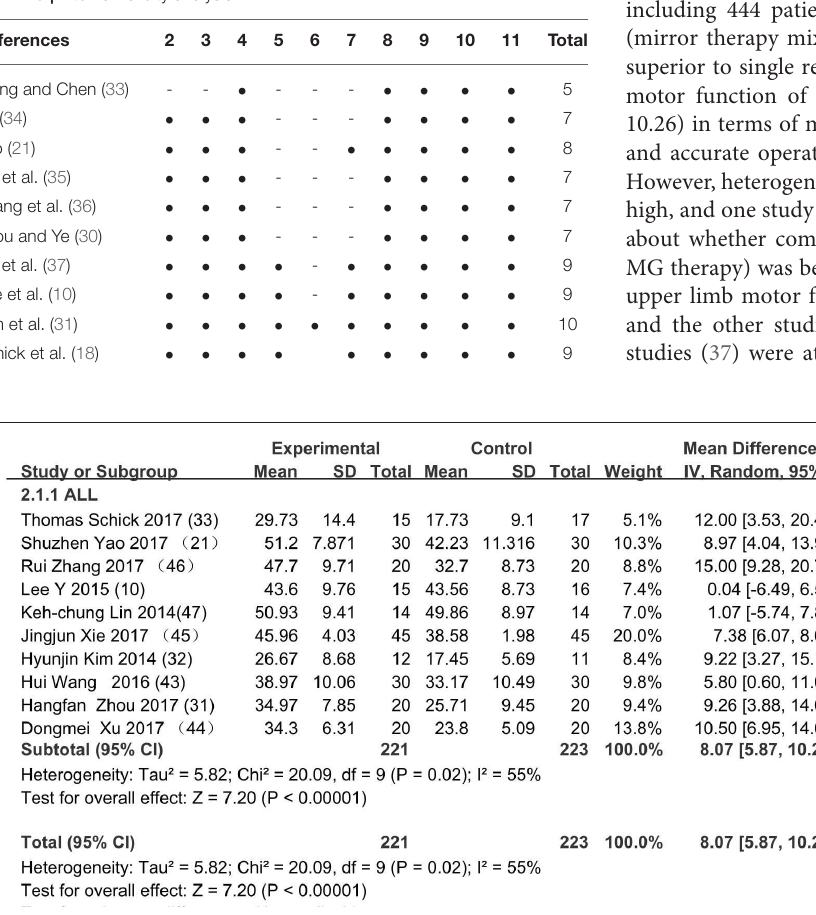
FIGURE 3 | Forest plot of the random effects meta-analysis of CT and MT on motor function of the upper extremity. SD: standard deviation; 95% CI: 95% confidence interval.